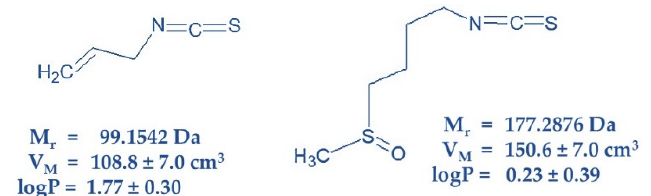
Figure 1. Structure of AITC (left) and SFN (right) characterized by physico-chemical constants Mr-relative molar mass; VM-molar volume and logP-logarithm of partition coefficient in two-phase mixture form by water and n-octanol. Structures were drawn, and physico-chemical constants were calculated using ACD / ChemSketch for academic and personal use (Advanced Chemistry Development, Inc., Toronto, ON, Canada).